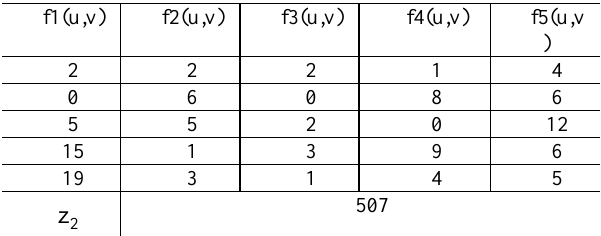
In Figure 7, k p  is a measure for variety of flows in the network, with k number of the products and p number of the basic components. Moreover, k  , assuming an average 4 components per